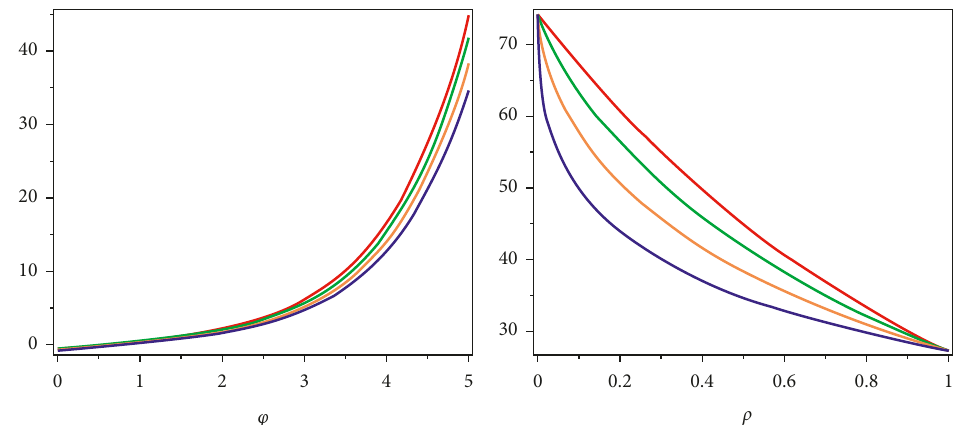
Figure 4: The graph of the two dimensions of different fractional orders at δ with respect to φ and ρ .